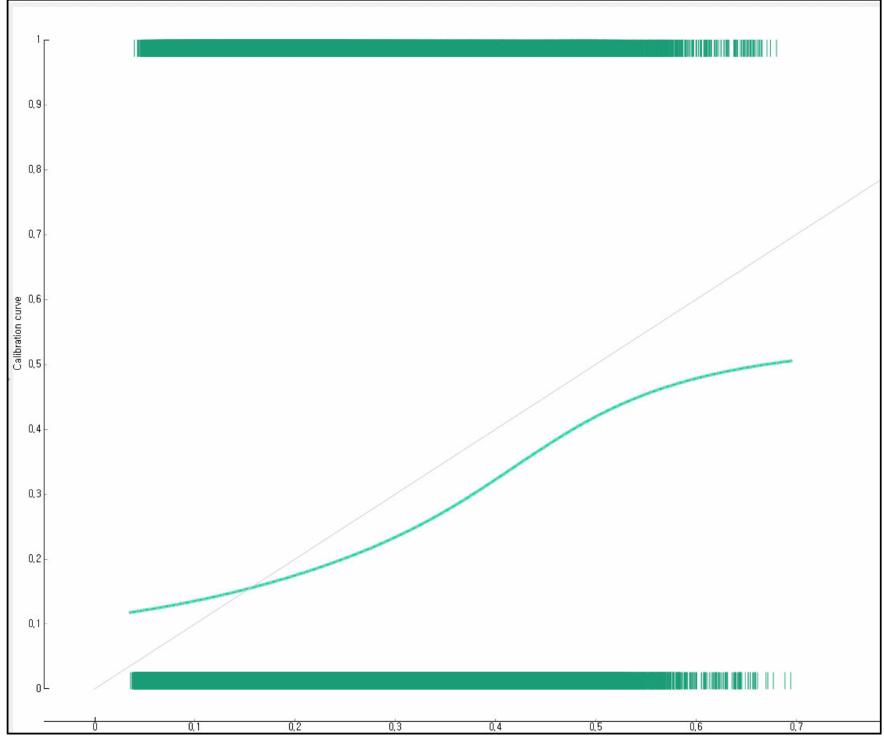
Figure 9. Calibration plot of the nomogram for predicting anxiety due to COVID-19 for adults living in South Korean communities: dashed line, an ideal nomogram; solid line, performance of the present